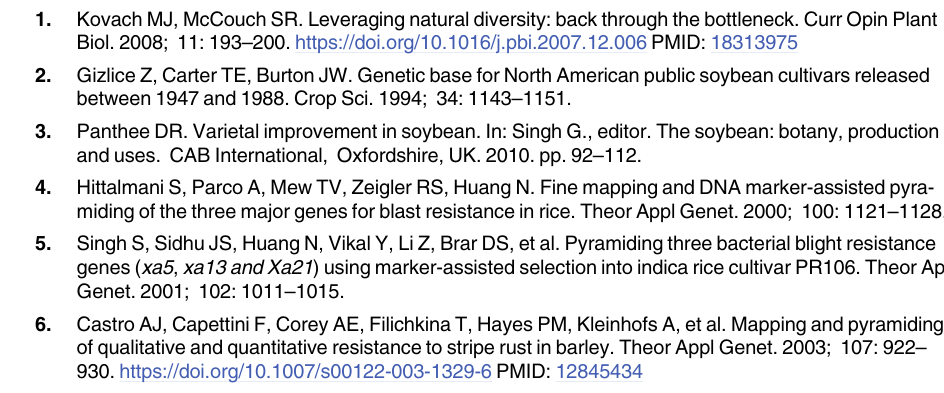
S4 Table. Results of whole-genome based RIL pedigree